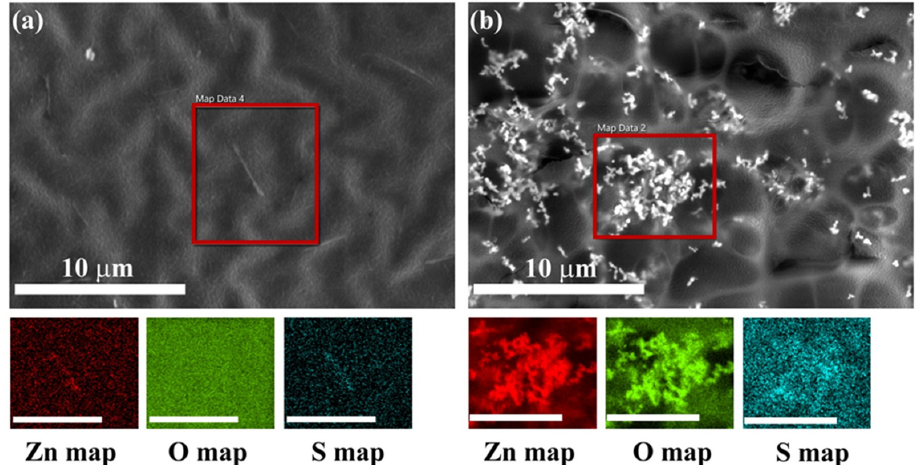
Figure 6. BSE-SEM image of binder-A loaded with ( a ) ZnO-aloe and ( b ) ZnO-starch particles with EDXS elemental maps of Zn, O, and S. Scale bar on the elemental maps is 5 µm. The red frame in the BSE-SEM images indicates the area of analysis.